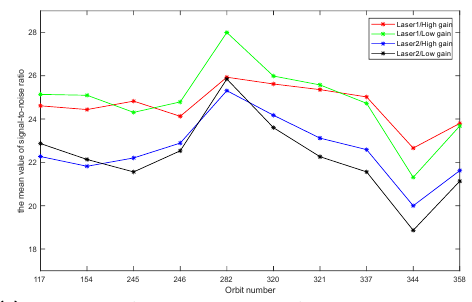
Figure 3. Analysis results of quality parameters of received waveform